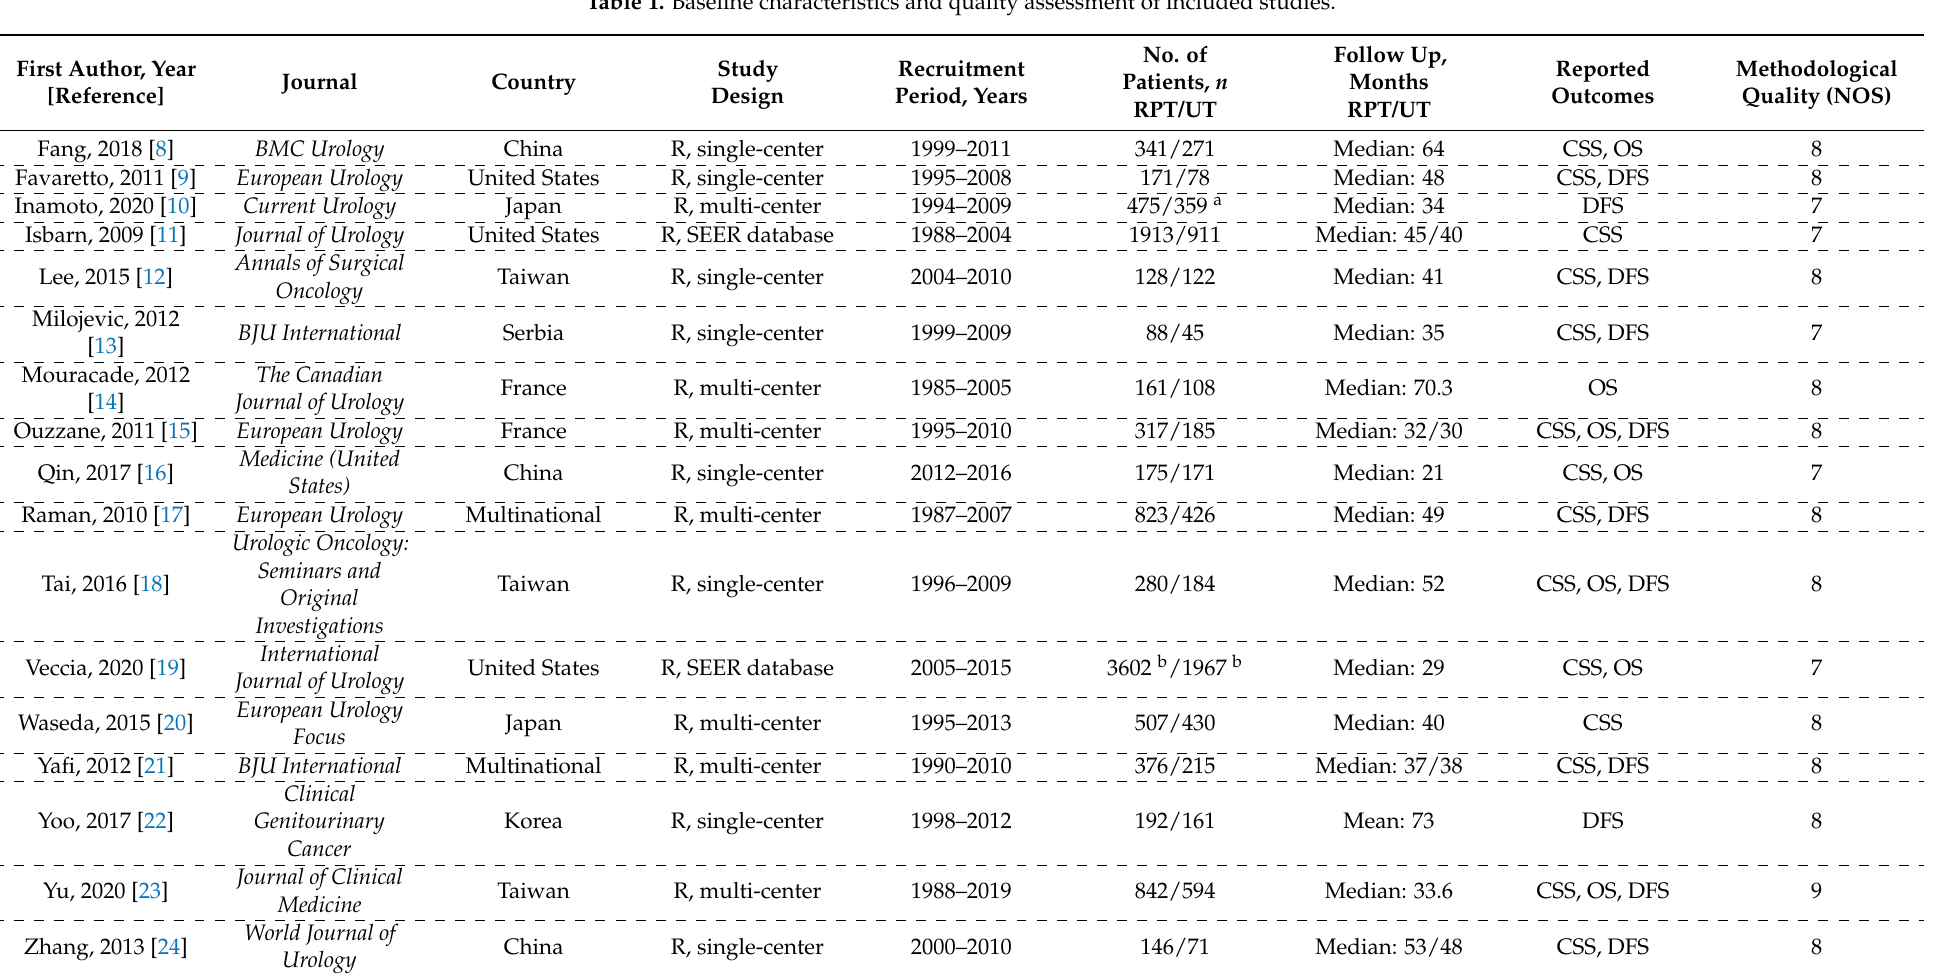
Table 1. Baseline characteristics and quality assessment of included